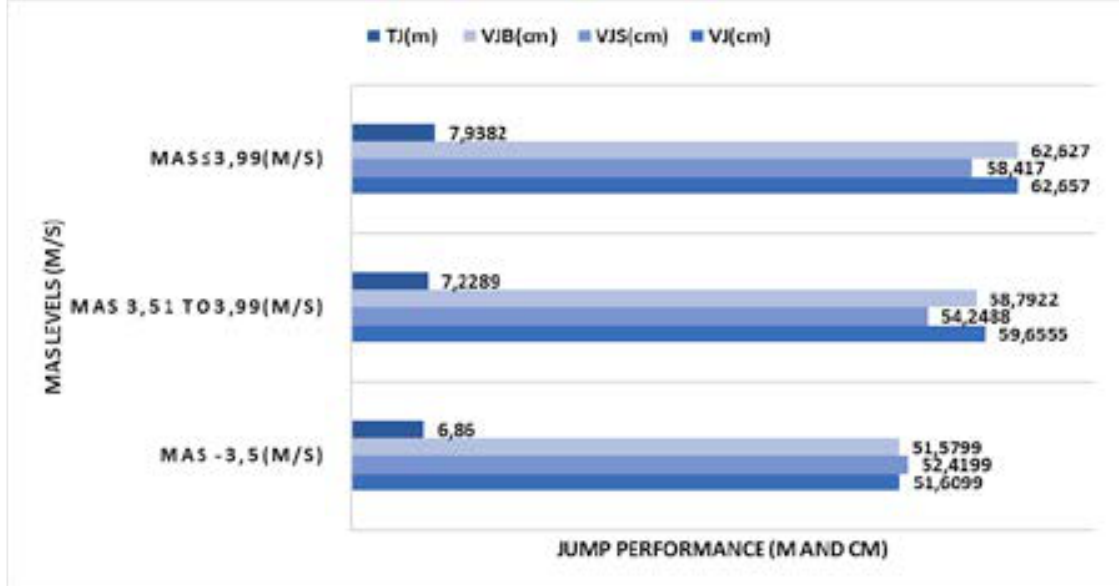
Figure1. Present the levels of Maximal Aerobic Speed (MAS) with •20-meter Sprint and T-agility